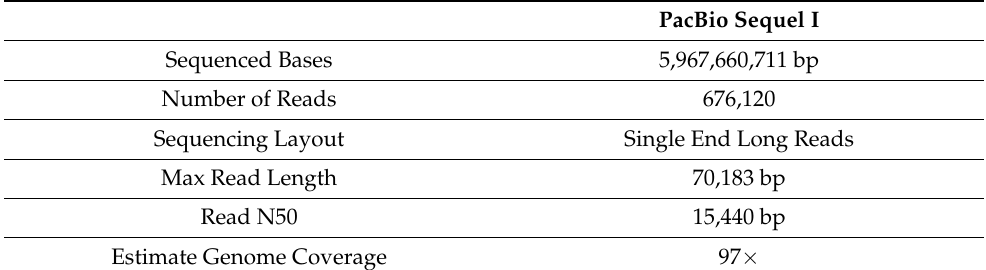
Table A1. Description of the raw DNA sequencing dataset used in this